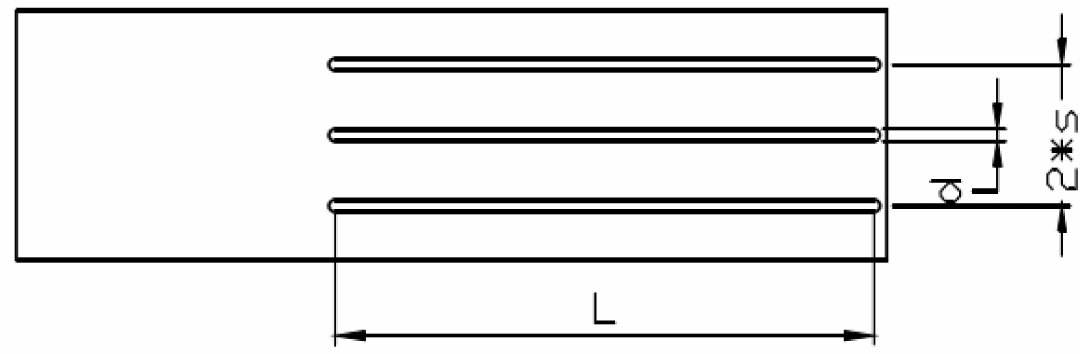
Figure 4. Probe structure